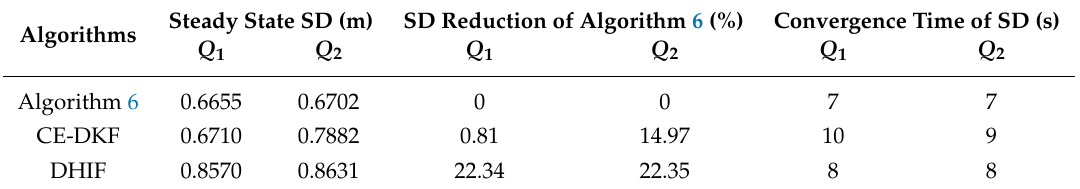
Table 2. Consensus performance comparison of different algorithms.